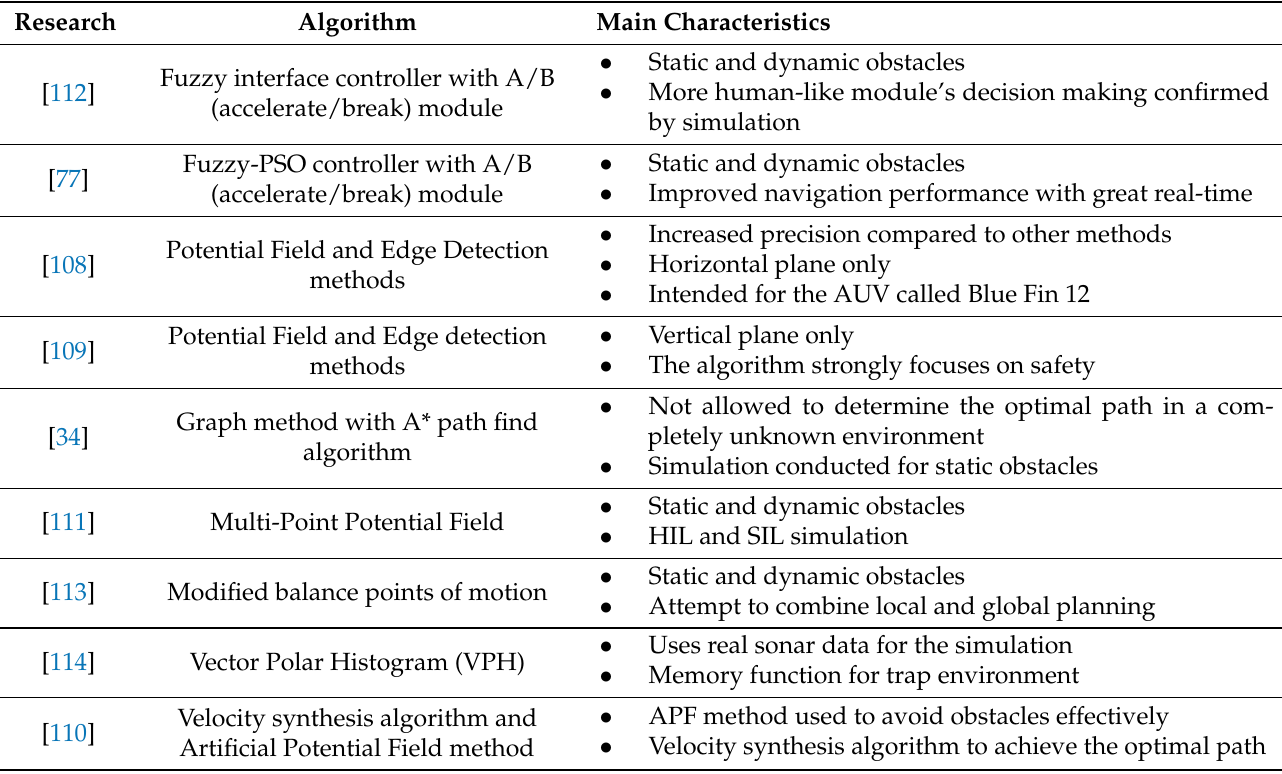
Table 4. List of algorithms validated in numerical research between